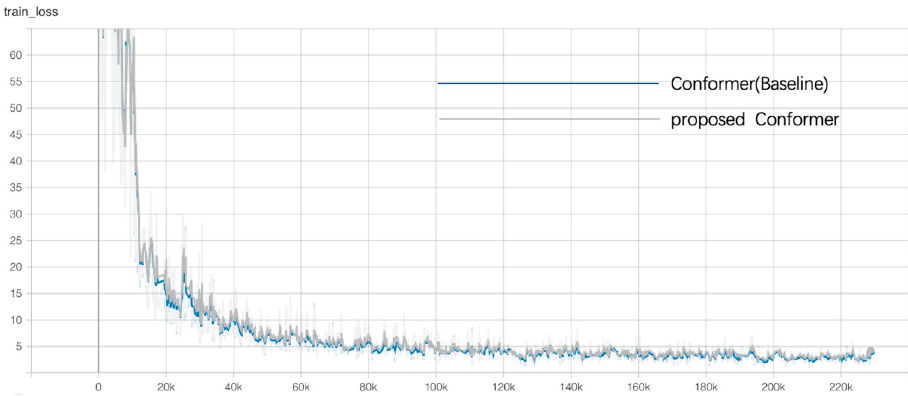
Figure 6. The train loss of the proposed efficient Conformer model and the baseline Conformer model.